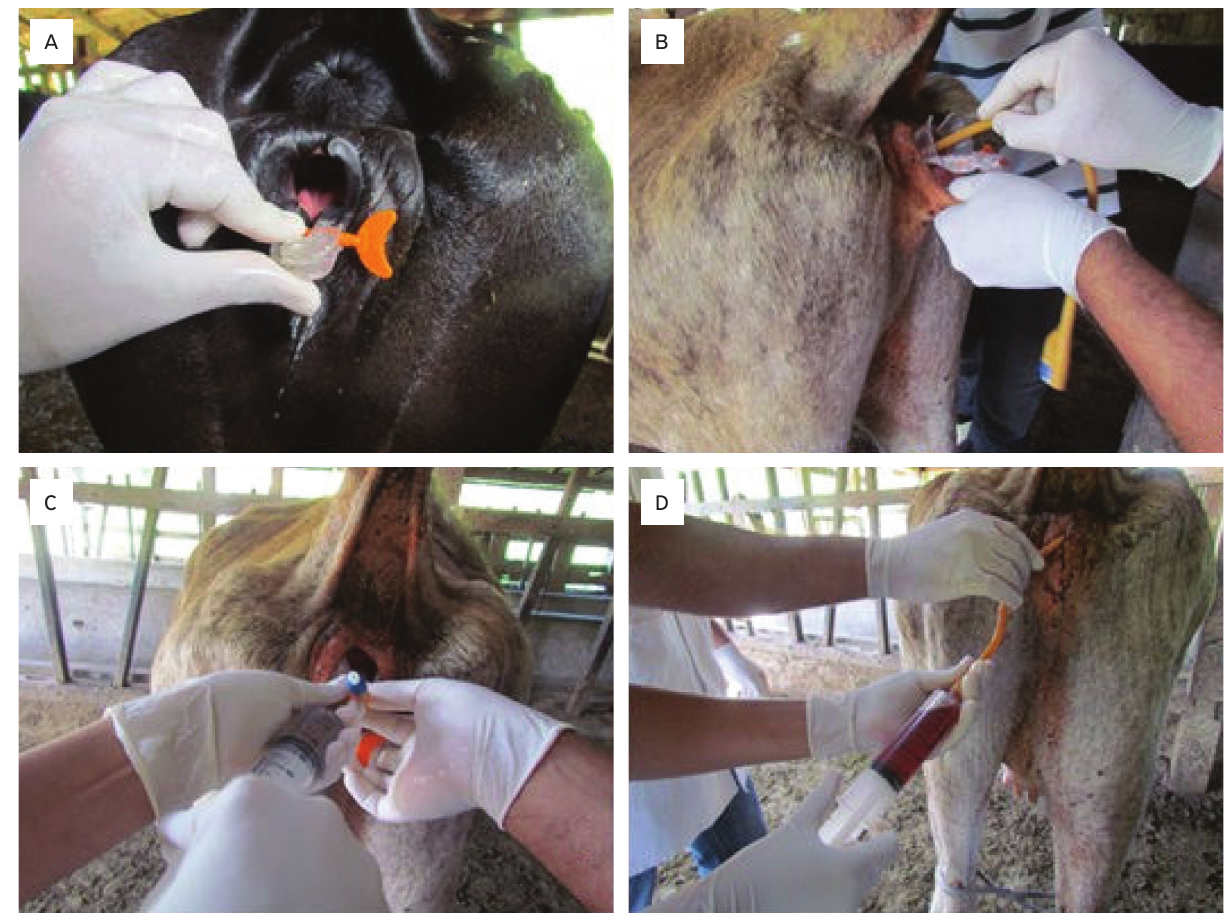
Figura 1. Coleta de lavado vesical em bovinos com hematúria enzoótica. (A) Localização do meato urinário externo; (B) introdução da sonda pelo meato urinário externo; (C) infusão da solução fi siológica (NaCl 0,9%); (D) processo de turbilhonamento do lavado.